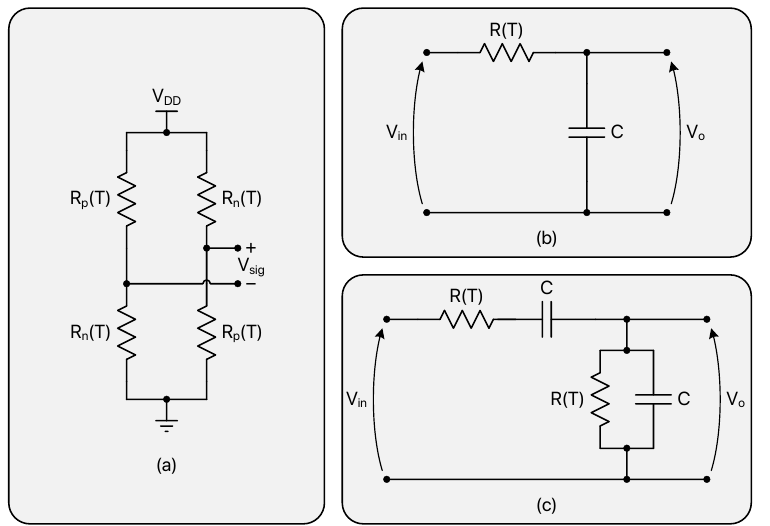
Figure 5. Main circuits used to extract temperature information from the thermal behaviour of integrated resistors: Wheatstone bridge ( a ); RC filter ( b ); Wien-bridge filter ( c ). TDCs based on Wheatstone bridges [28,31,69–72] typically rely on the combined effect of a positive TC resistor ( R p ) and of a negative TC one ( R n